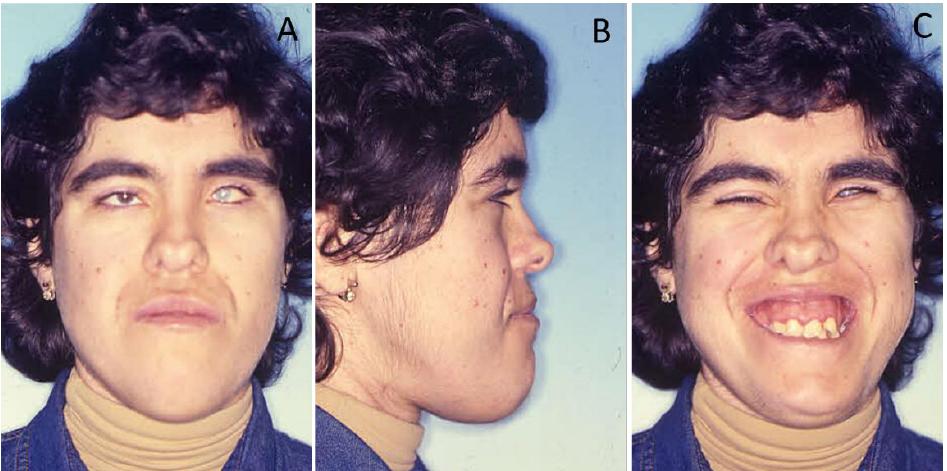
Figure 1. Pre-treatment extra-oral photographs of the oculo-facio-cardio-dental (OFCD) syndrome patient showing facial and dental characteristics of the OFCD syndrome in frontal ( A ), profile ( B ), and smile ( C ) photographs.